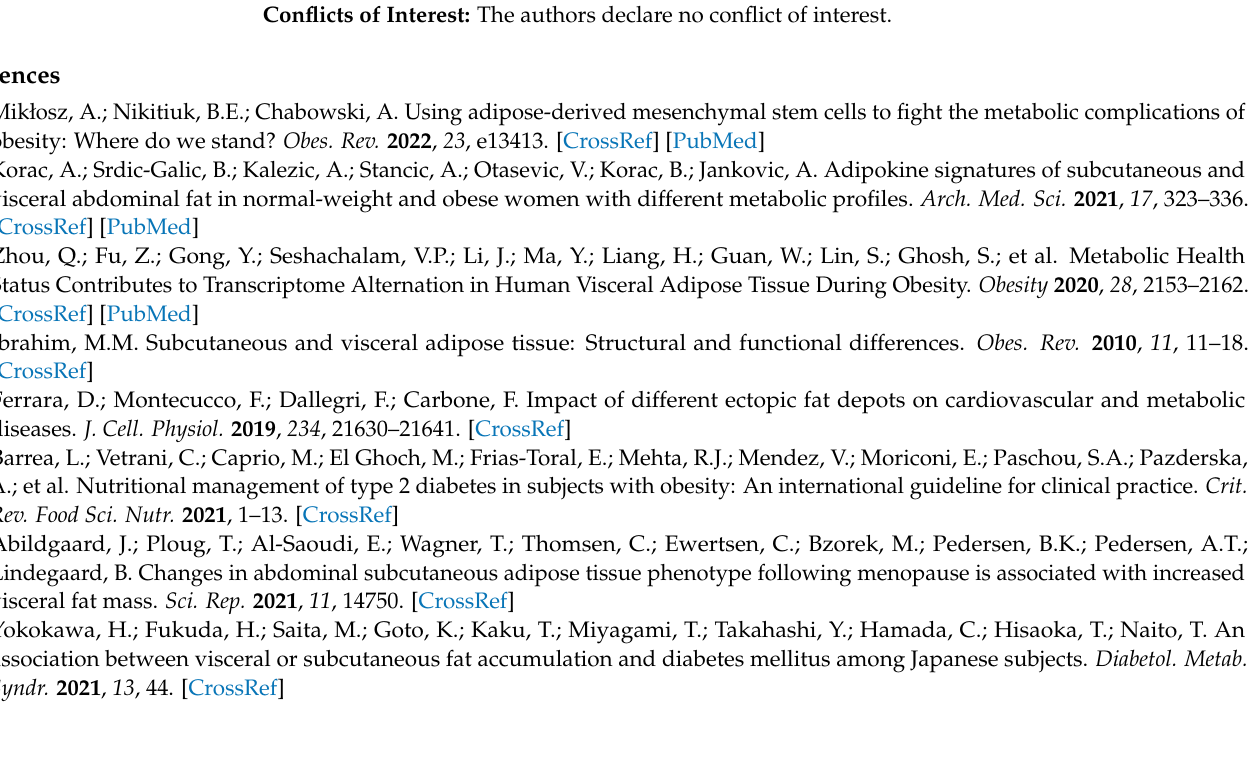
protein), Table S5: TAG—Fatty acid composition (nmol/mg of protein), Table S6: Summary table of ANOVA